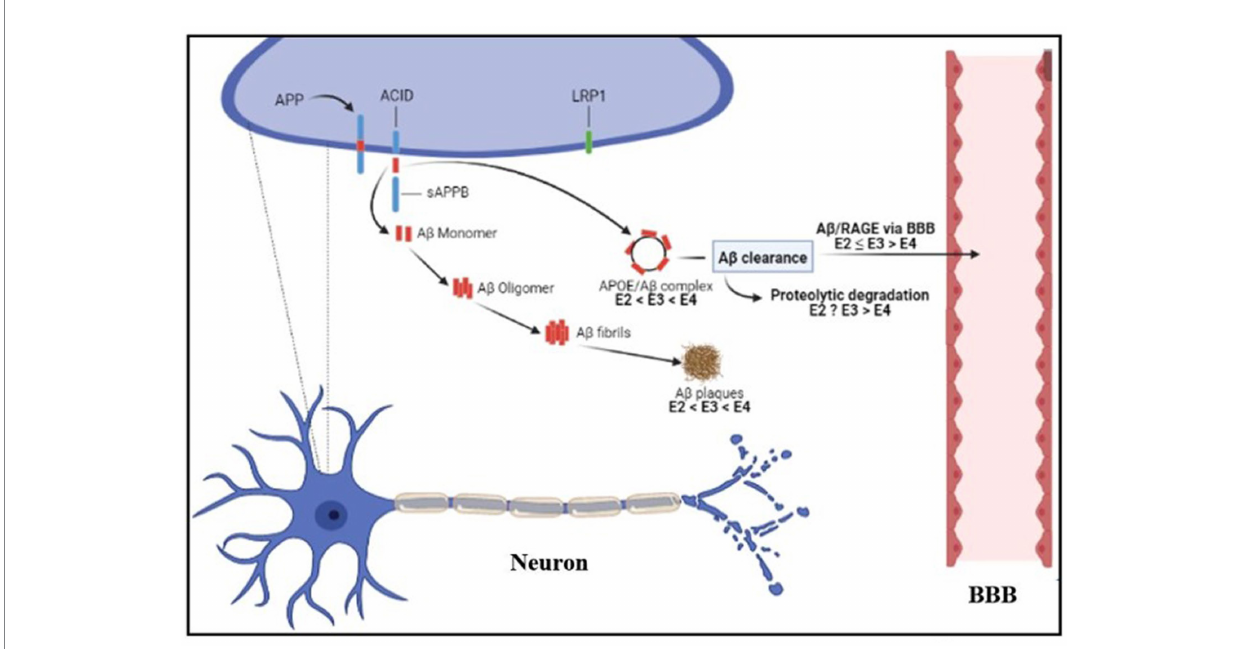
FIGURE 3 Diagrammatic representation of the regulatory systems for A β in an AD patient’s brain. A β , amyloid-beta; BBB, Blood–brain barrier; RAGE, Receptor for advanced glycation end products; AICD, APP intracellular C-terminal domain; APP, Amyloid precursor protein; ApoE, apolipoprotein E; E4, ApoE; E3, ApoE3; E2, ApoE2. Created with